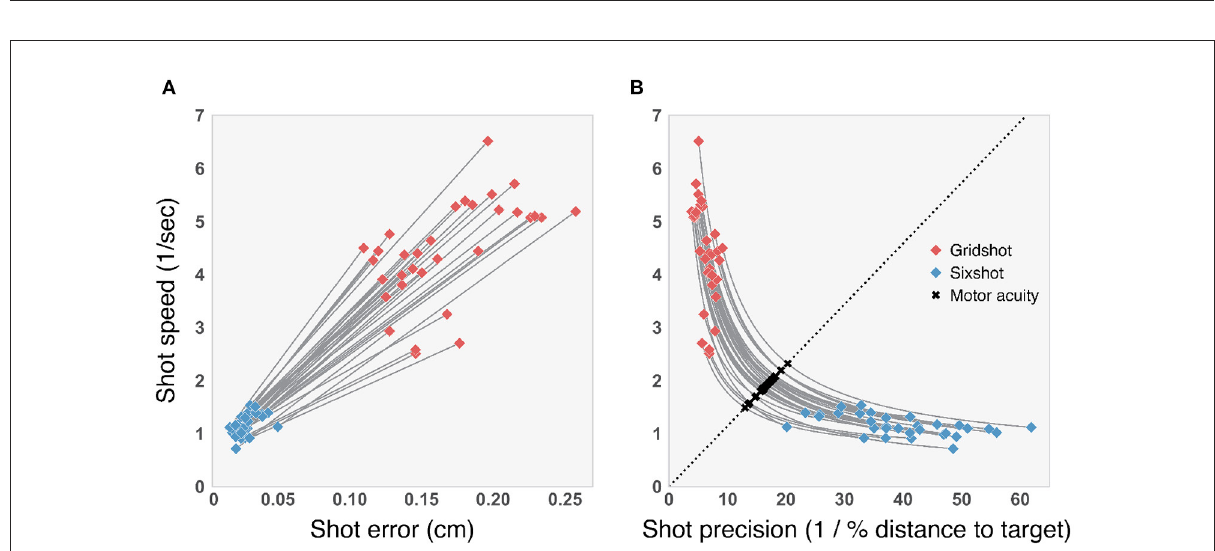
FIGURE4 (A) Shot speed vs. shot error. Solid lines illustrate the line of best fit for each player by task (see Legend). (B) SAT curves. Dashed line spans from (0, 0) to three-times the standard deviation, plus the mean of the distribution of shot precision (x-axis) and shots speed (y-axis). The intersection of individual curves with the diagonal, marked with “ × ,” indicates motor acuity (arbitrary units).